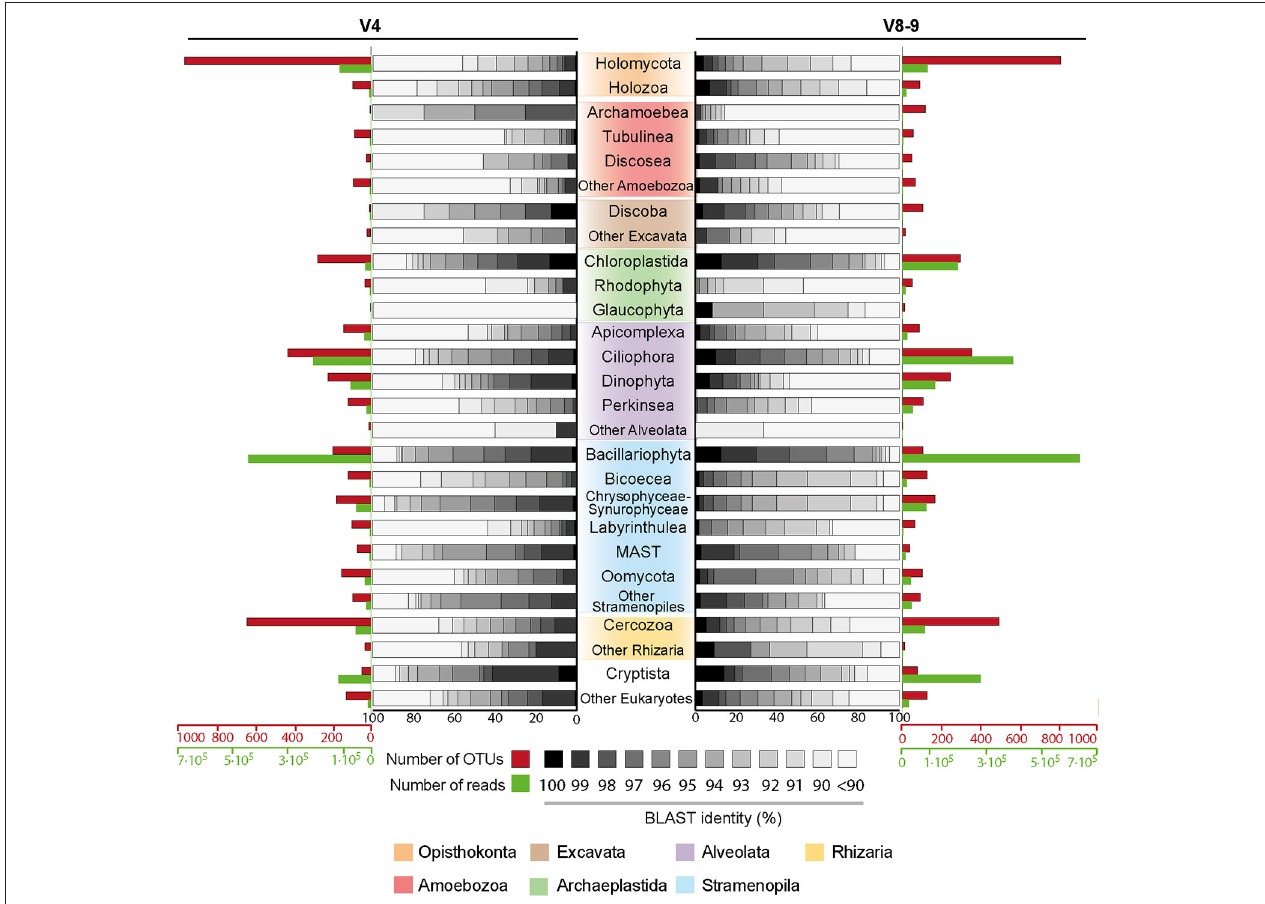
FIGURE 2 | Eukaryotic diversity in Paraná River represented by V4 and V8-9 regions of 18S rRNA gene. Eukaryotic classification follows Adl et al. (2012). External barplots show the richness (number of OTUs) in red and the abundance (number of reads) in green for each eukaryotic group. Inner histograms show the distribution of percentages of blast identity against our reference database adapted from PR2 (see Materials and Methods) in every group.